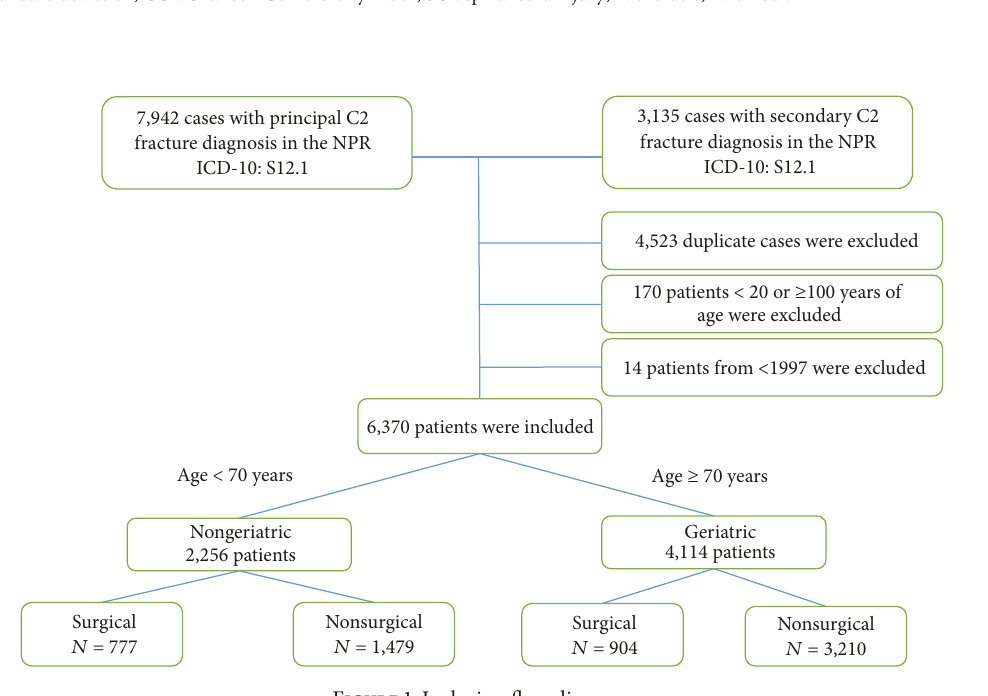
Figure 1: Inclusion flow